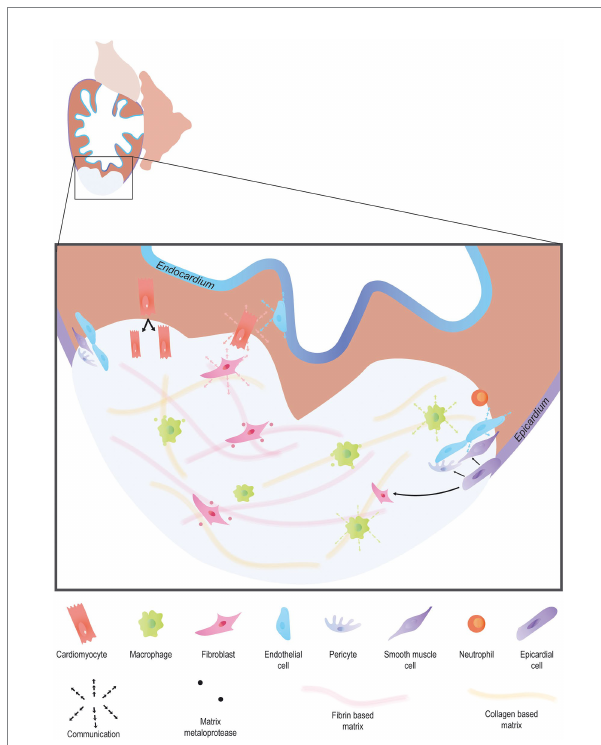
FIGURE 1 Endogenous heart regeneration. Following an injury, the majority of cardiac interstitial cells are involved in the process of regeneration. Immune cells invade the wound to clear debris and secrete cytokines to promote the fast resolution of the pro-inflammatory phase. Pro-angiogenic factors are secreted by a large variety of cardiac cell types to promote angiogenesis. Activated epicardial cells undergo EMT, forming epicardium-derived cells including fibroblasts, and vascular cells. In turn, fibroblast activation allows matrix remodeling, first via the secretion of a transient collagen-based matrix which is then degraded leaving room for a fibrin-based matrix. Finally, cardiomyocytes proliferate, forming new and functional myocardial